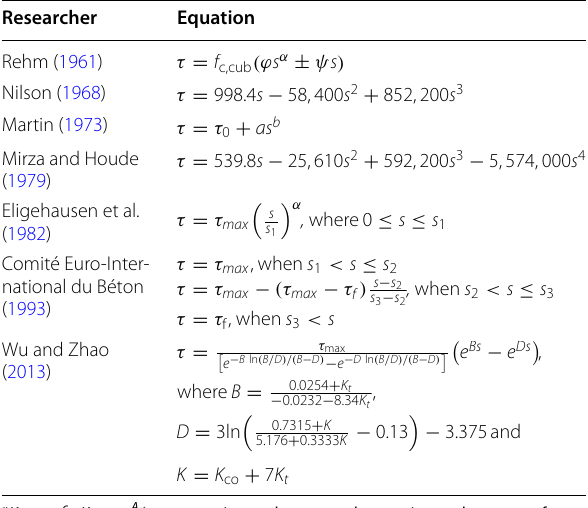
Table 2 Empirical bond–slip